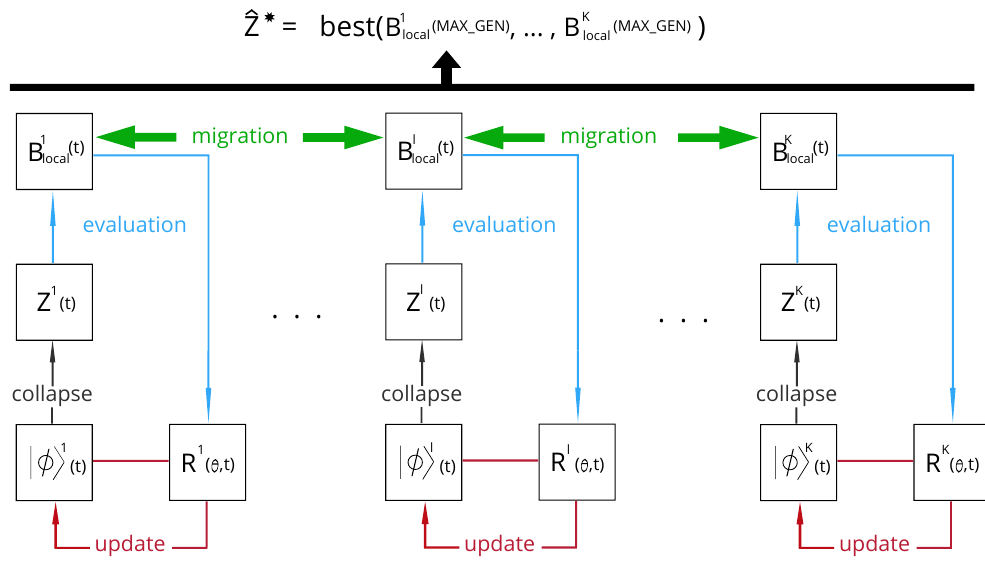
Figure 3. Scheme of the QiEA procedure considering K initial